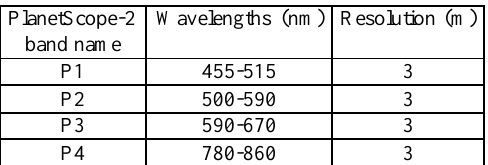
Dove Classic nanosatellite (1-day revisit and a frame size of 24